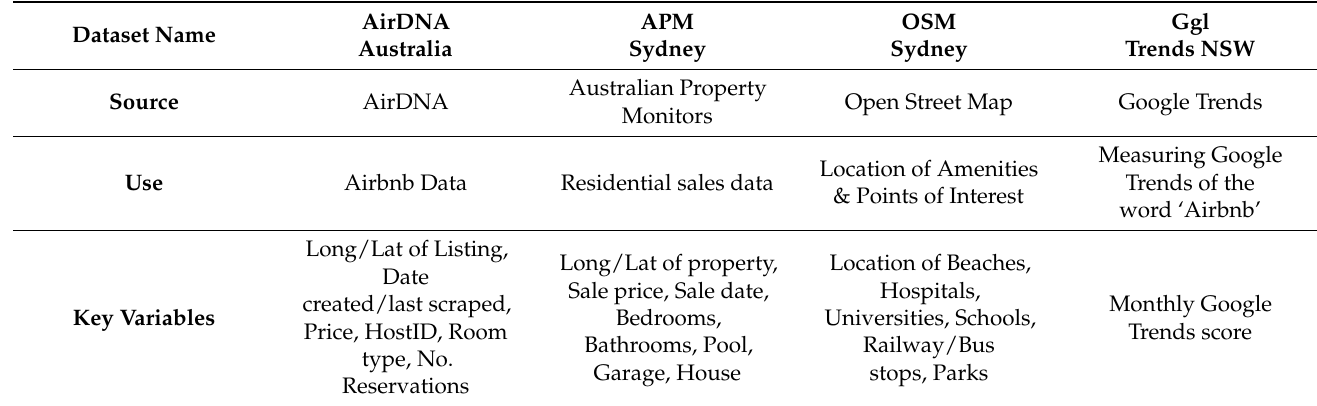
Table 1. Summary of data sources, use and key